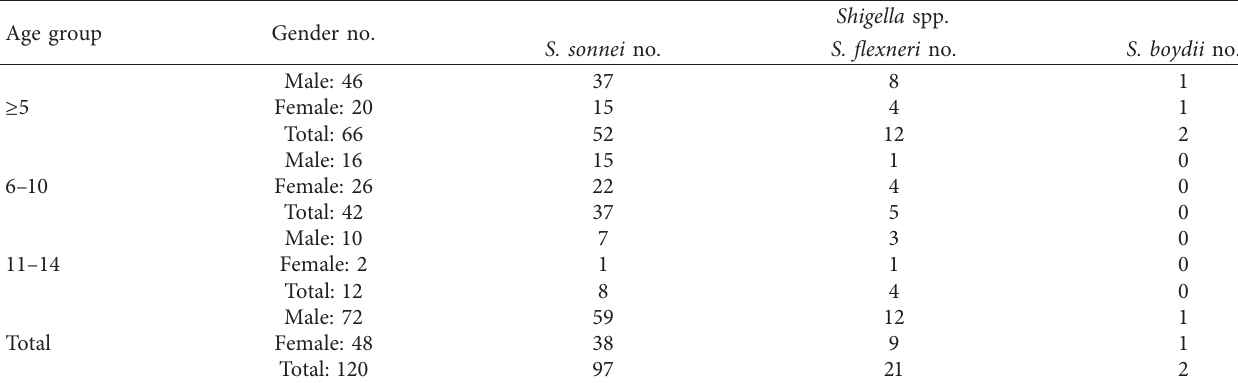
Table 2: Characteristics of the patients with